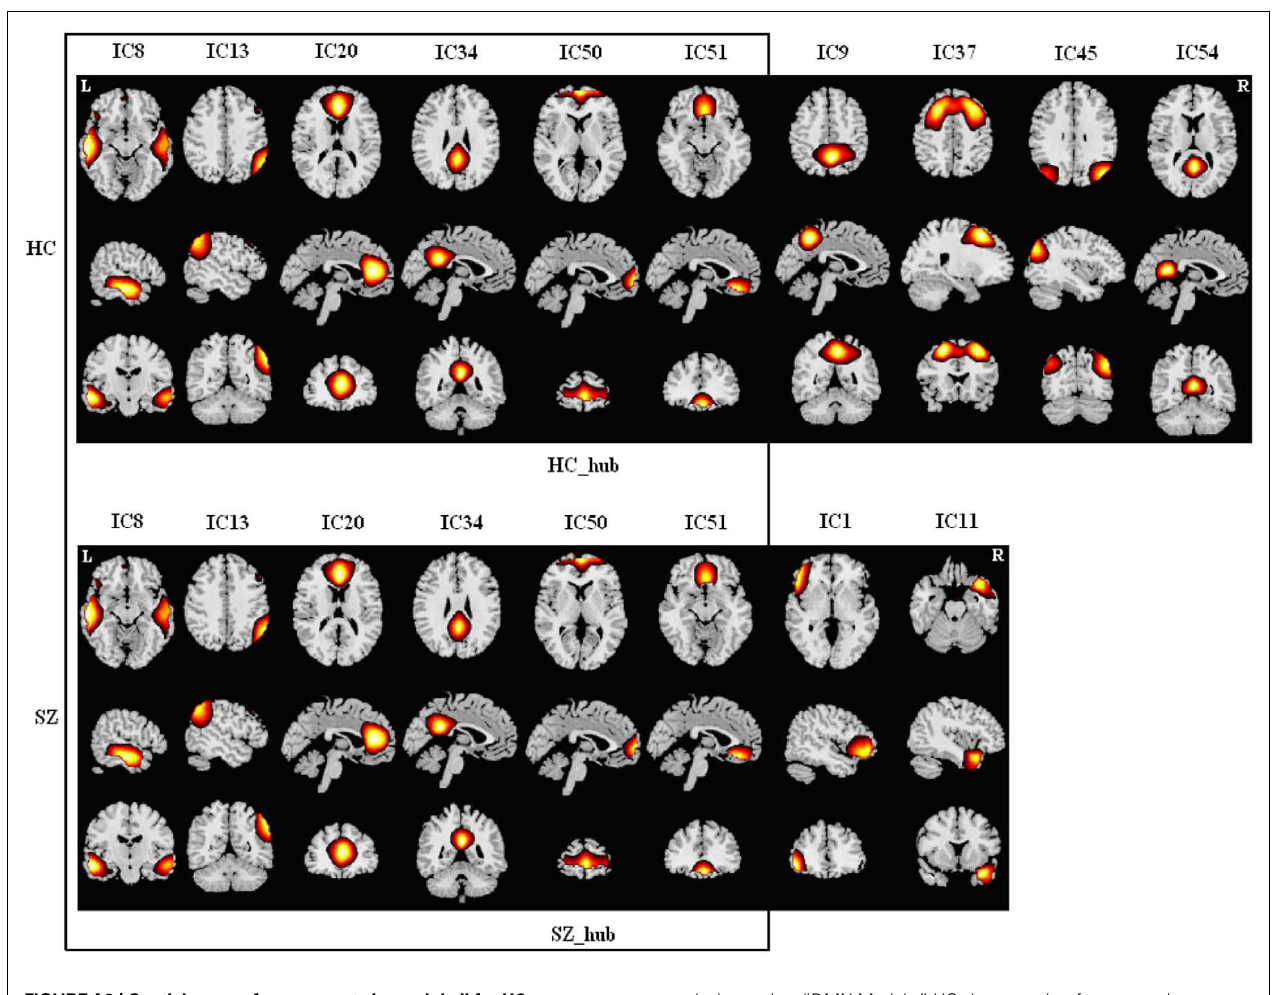
FIGUREA2 | Spatial maps of components in module II for HCs (upper) and SZs (lower). Hubs of each module are labeled. Each column shows one component in axial, sagittal, and coronal views. There are six common components [in the box, most of which are default mode network (DMN) areas] between the groups.This module